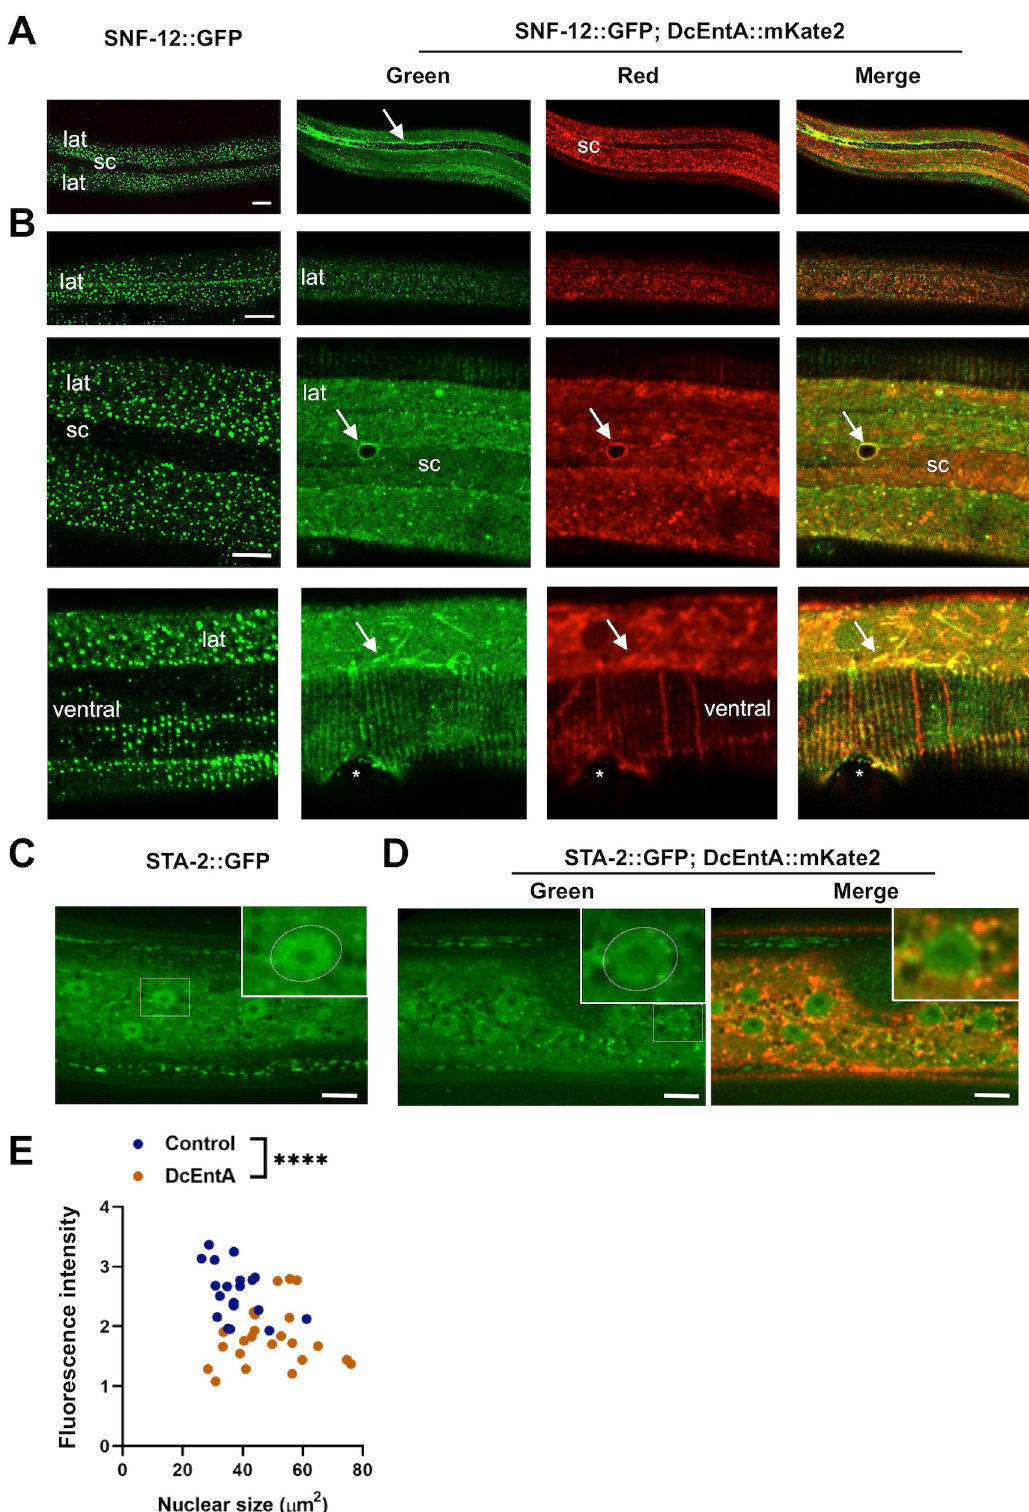
Fig 4. DcEntA alters the localisation of key immune regulatory proteins. ( A , B ) DcEntA disrupts the vesicular pattern of SNF-12 in the epidermis. Confocal images of adult worms expressing SNF-12::GFP together with DcEntA::mKate2